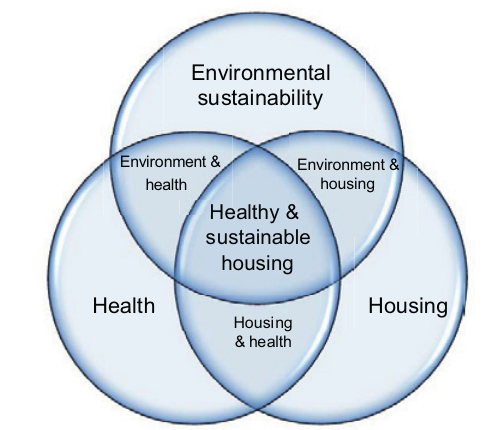
Figure 2. Guiding framework for review of health and sustainable housing